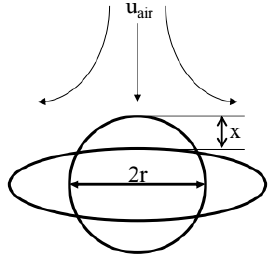
Figure 4. TAB model analogy